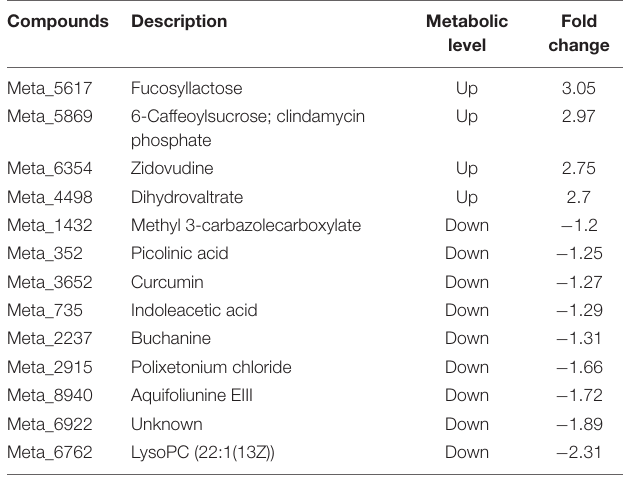
TABLE 7 | Thirteen differential metabolites detected in the Ri + Pf + Th + Fo treatment compared with Fo treatment from tomato shoots. Compounds Description